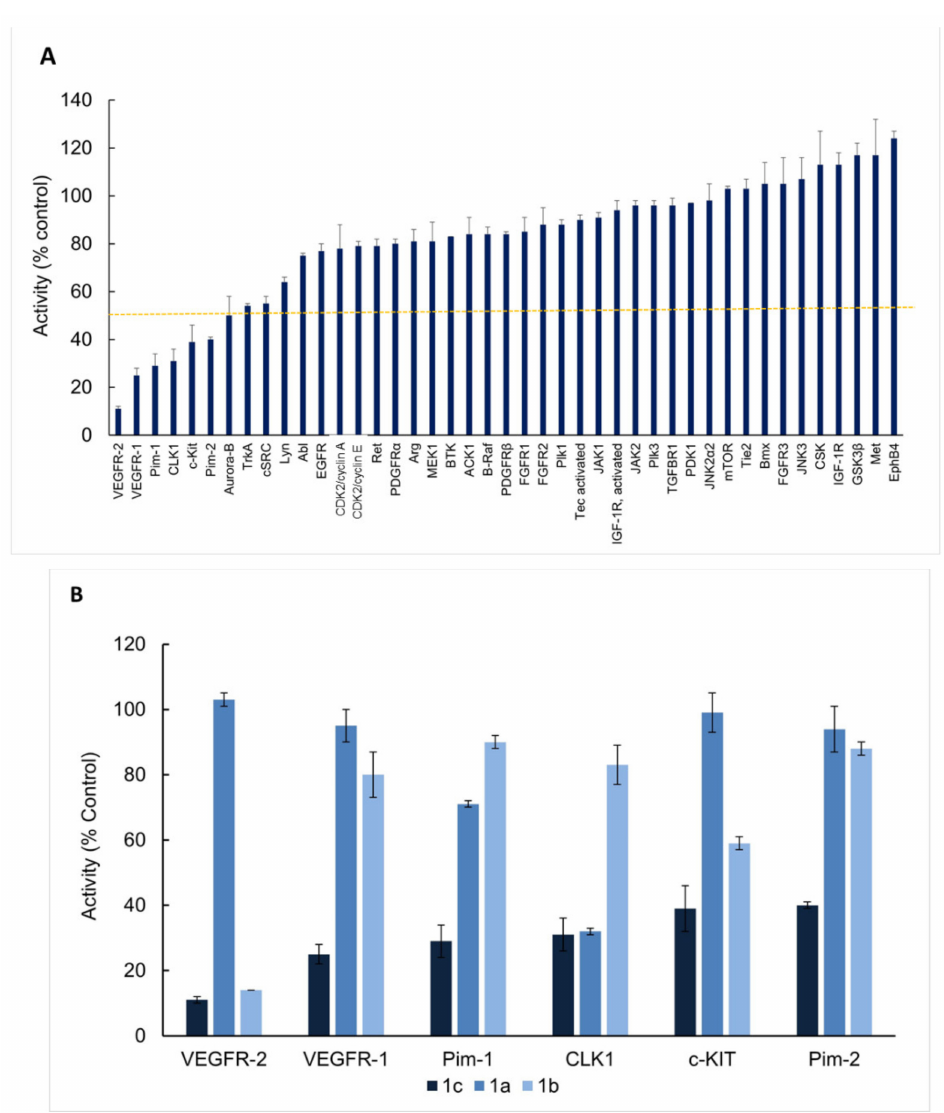
Figure 5. ( A ) Enzymatic assay screening results for compound 1c on a panel of 43 kinases. ( B ) Screen- ing results for compounds 1a , 1b and 1c against a subpanel of six protein kinases. Kinase profiling was performed in duplicate with 10 µ M of either compound employing Eurofins KinaseProfiler TM service. Data are given as mean values ± SD of kinase activity in %, as compared to non-treated kinases